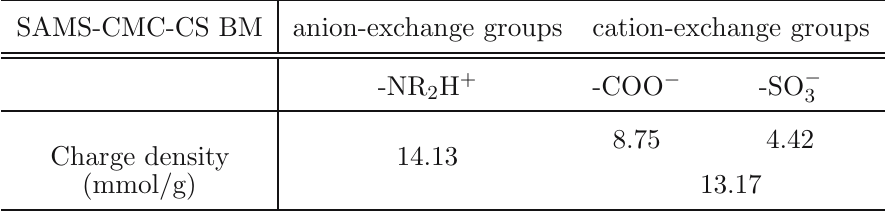
Fig. 7 Charge density of anion-exchange layer (A) and cation-exchange layer (B). the cation-exchange layer and -N=CRH + in CS anion-exchange layer respectively, and 2 in this way the recombination of H + and OH − were successfully restrained. During the electrolysis, a low voltage of about 1.9 V was obtained, which led to the prevention of a side reaction generating O 2 on the surface of the anode. Table 1 Charge density of different functional groups in SAMS-CMC-CS BM.